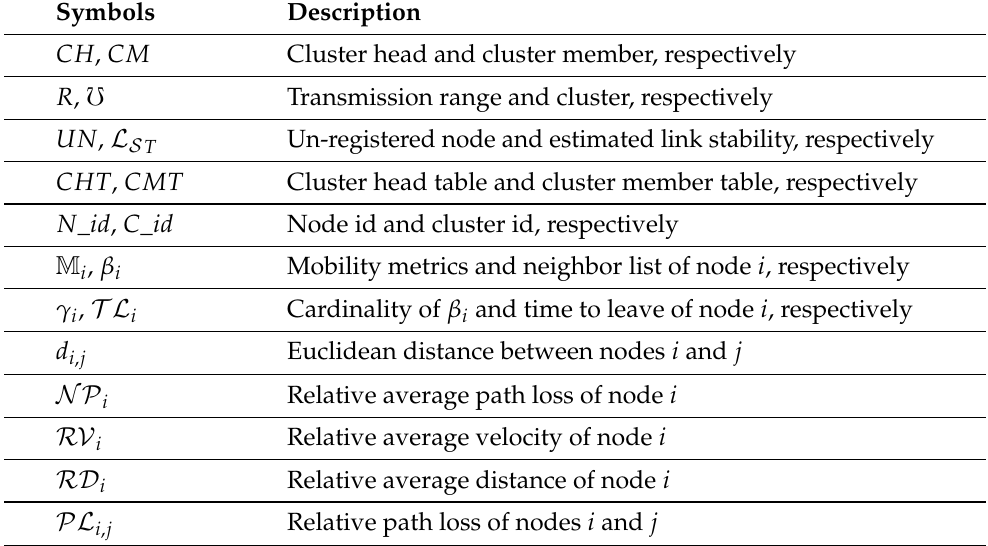
Table 2. List of